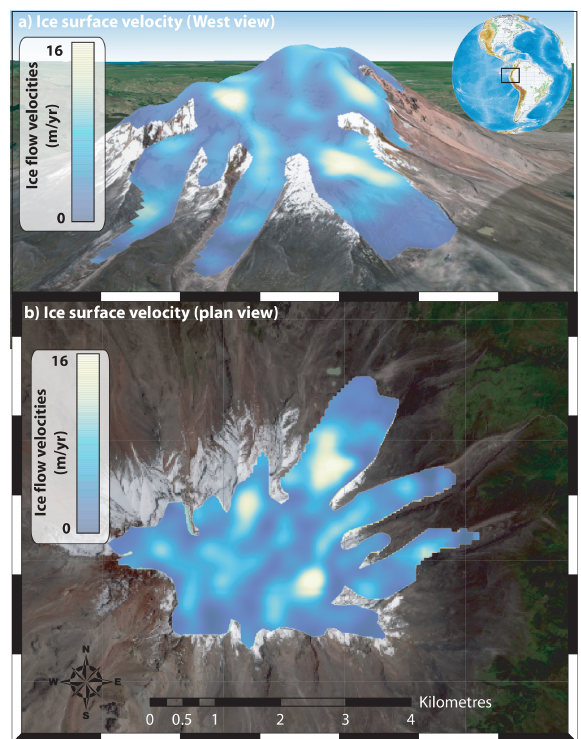
Figure 10. Ice-surface-velocity map for the Chimborazo glaciers calculated with GIV. Imagery © Google Earth and